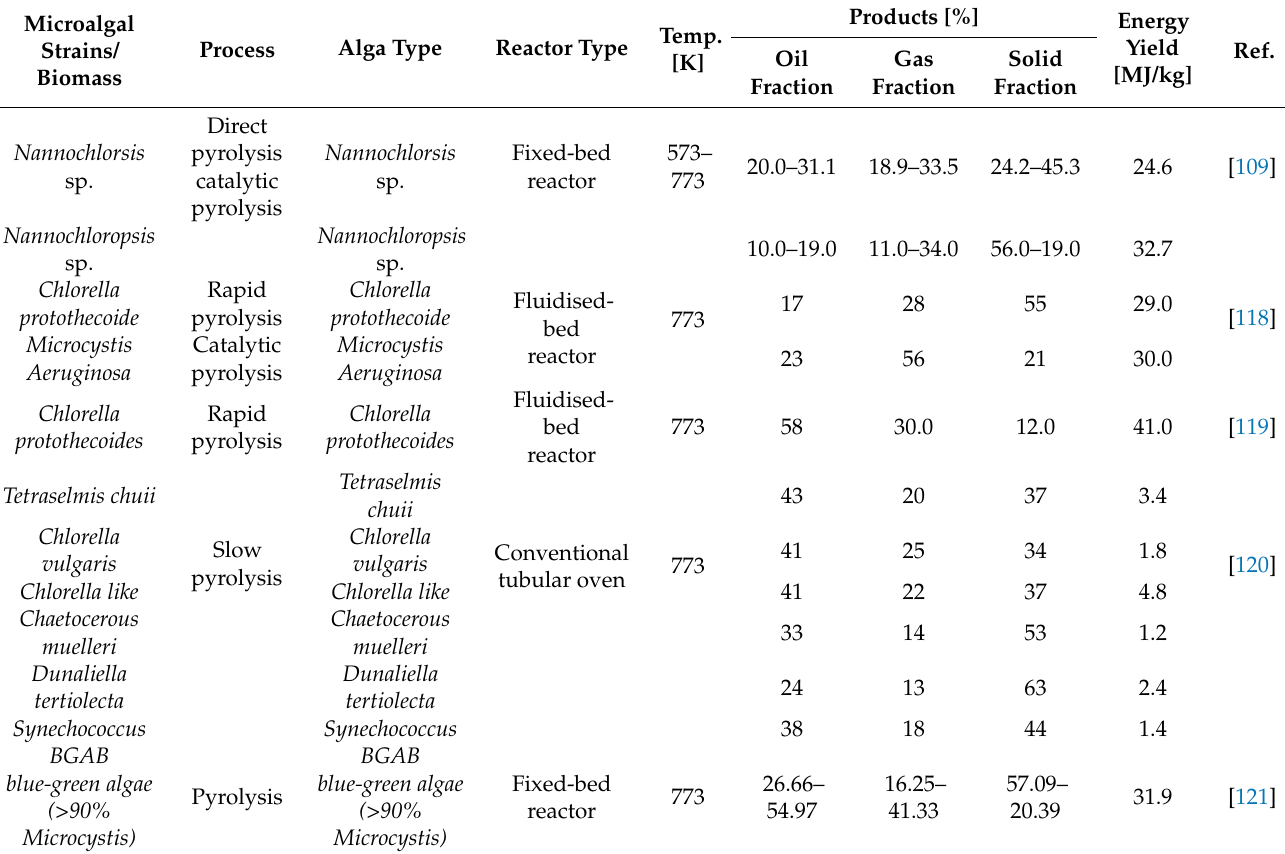
Table 1. Comparison of pyrolysis products from different taxonomic groups of